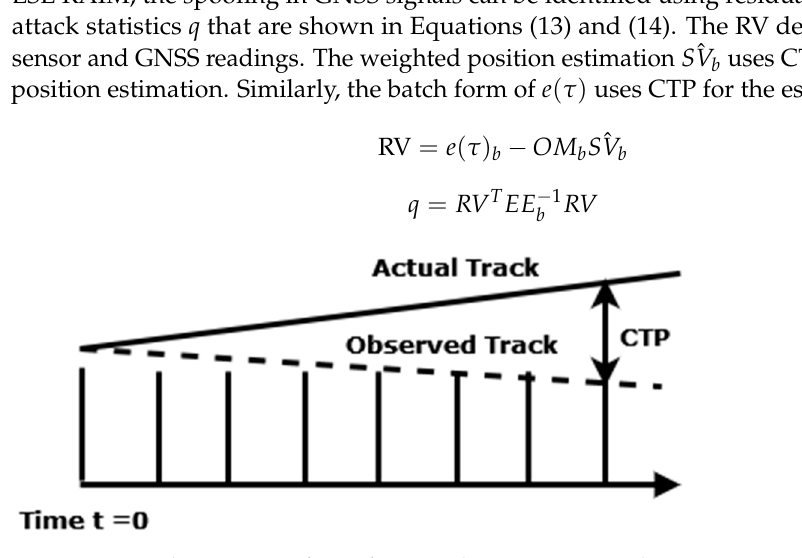
𝜃 (cid:2868) is the rudder angle with